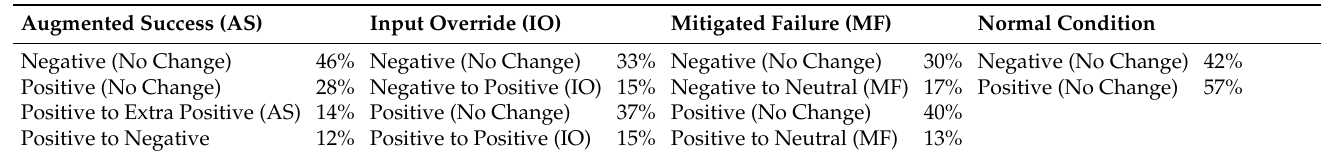
Table 1. Trials were manipulated by the urn model to target 30% help and limit control in help conditions. The table shows the mean % of how help conditions changed the outcomes as described in Section 2.3.1, compared to the normal condition (reference condition).